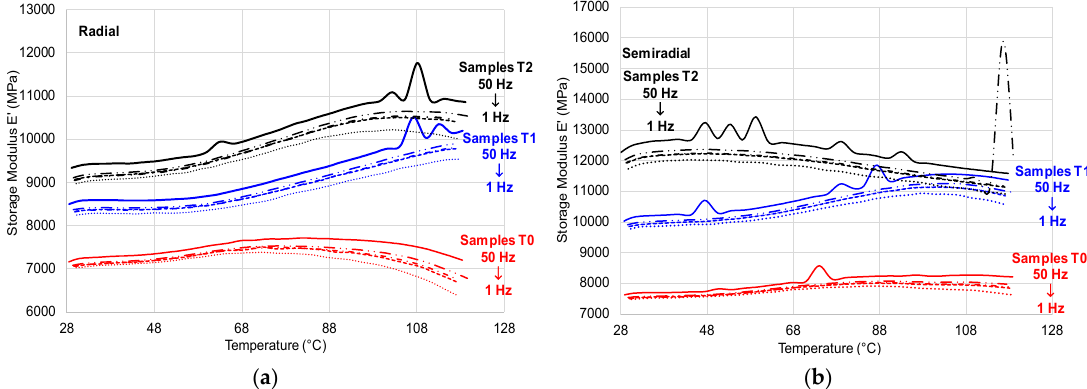
Figure 13. Variation of storage modulus E ’ versus temperature: ( a ) samples cut in radial–longitudinal direction; ( b ) samples cut in semi-radial–longitudinal direction. Legend: red line—untreated samples; blue line—samples exposed to first ammonia treatment; black line—samples exposed to the second ammonia treatment; solid line (50 Hz); long dash dot dot line (10 Hz); dash dot line (5 Hz); square dot line (3.3 Hz); round dot line (1 Hz).